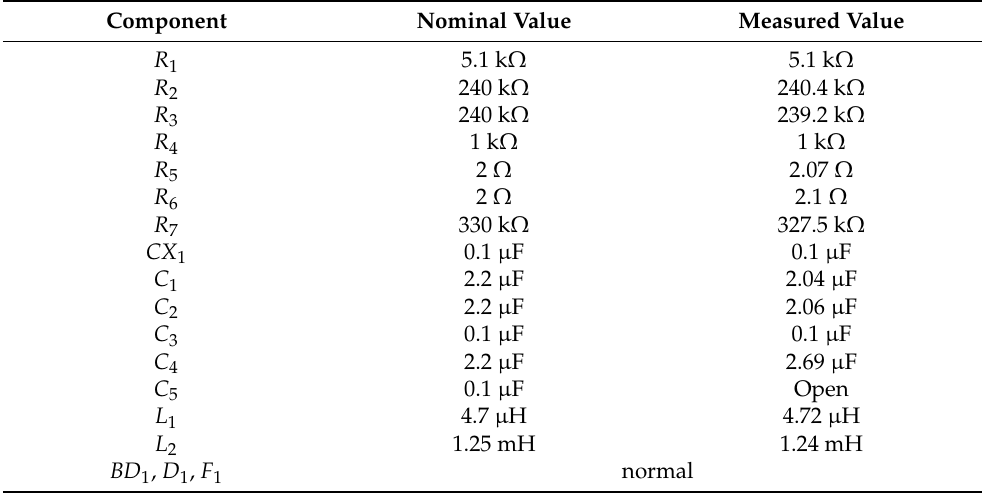
Table 5. Comparison of nominal and measured values of each component (Sample